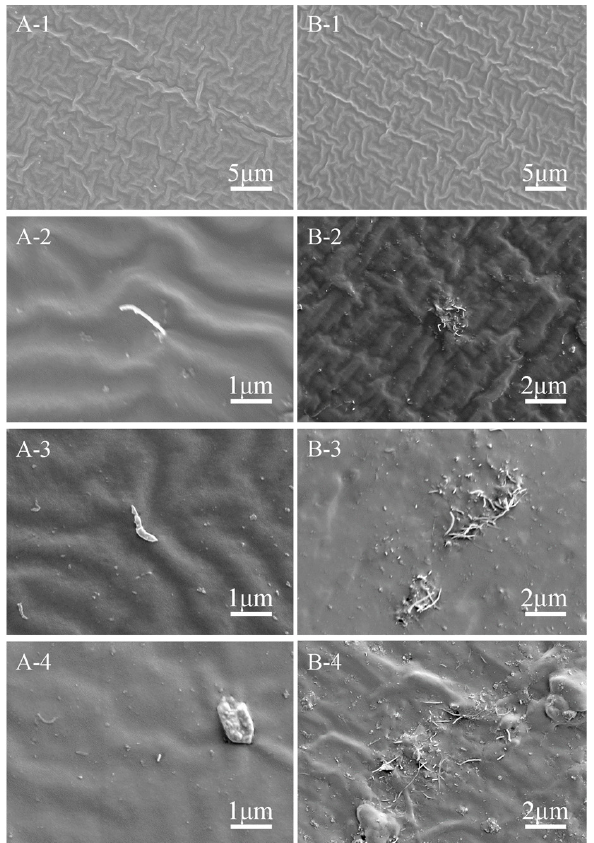
Figure 3. SEM images of the surfaces ( A ) and cross-sections ( B ); -1: pure PDMS; -2: PCSi1; -3: PCSi3; -4: PCSi5.